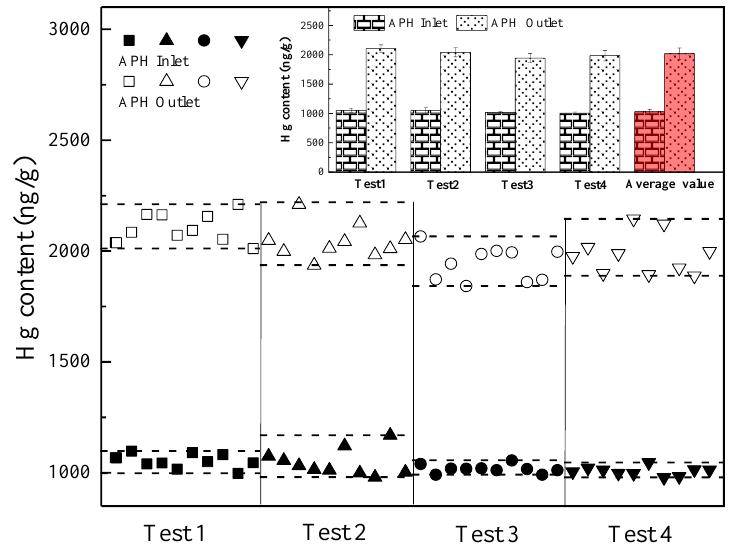
Figure 4. Hg contents in the fly ash samples collected from the inlet and the outlet of the APH.